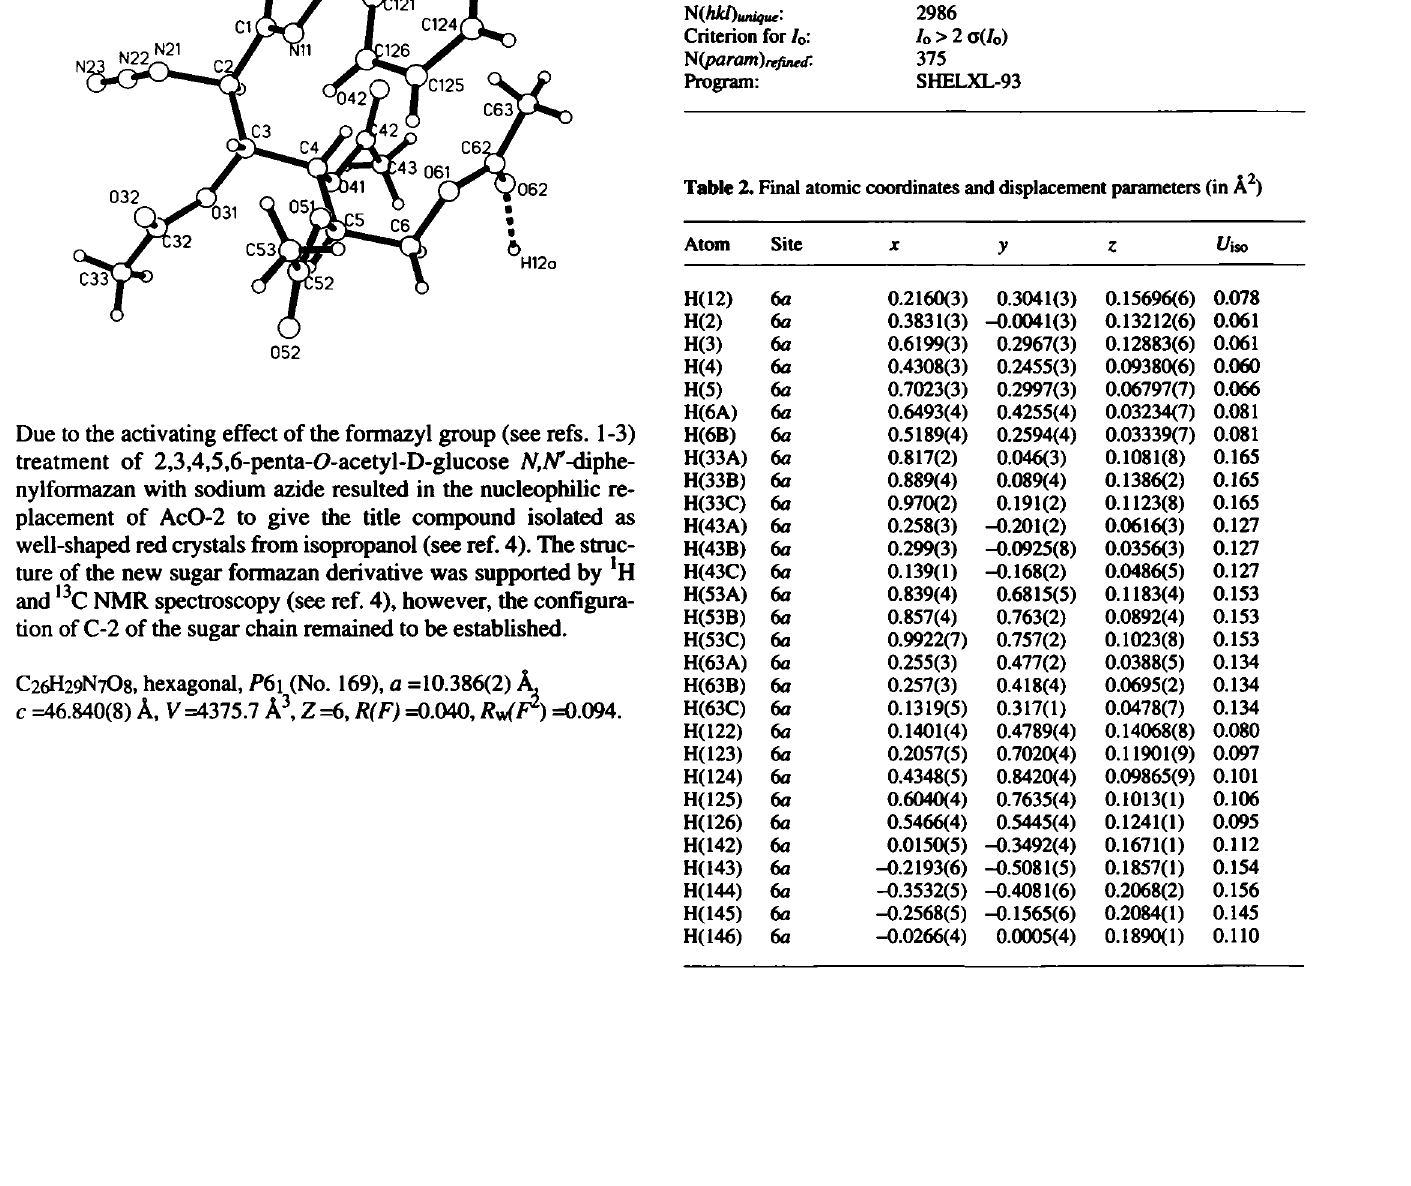
Table 2. Final atomic coordinates and displacement parameters (in Â 2